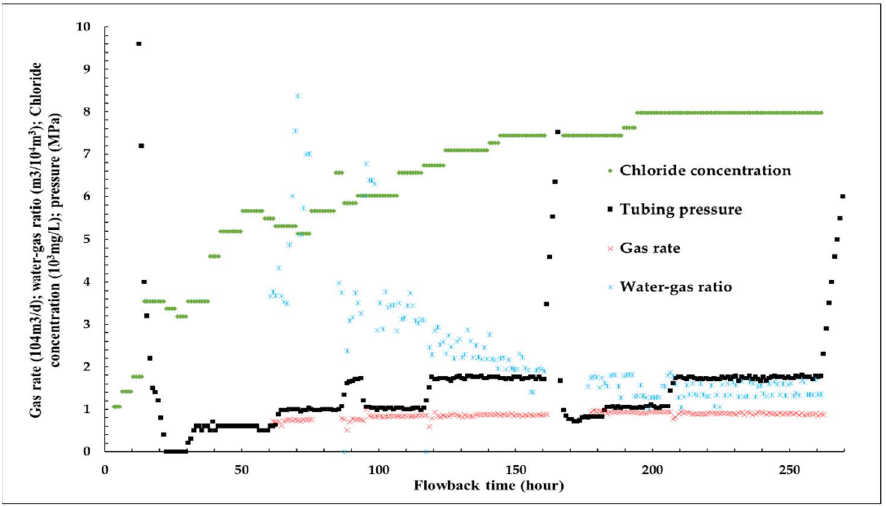
Figure 10. Flowback dynamic data to determine water production severity by